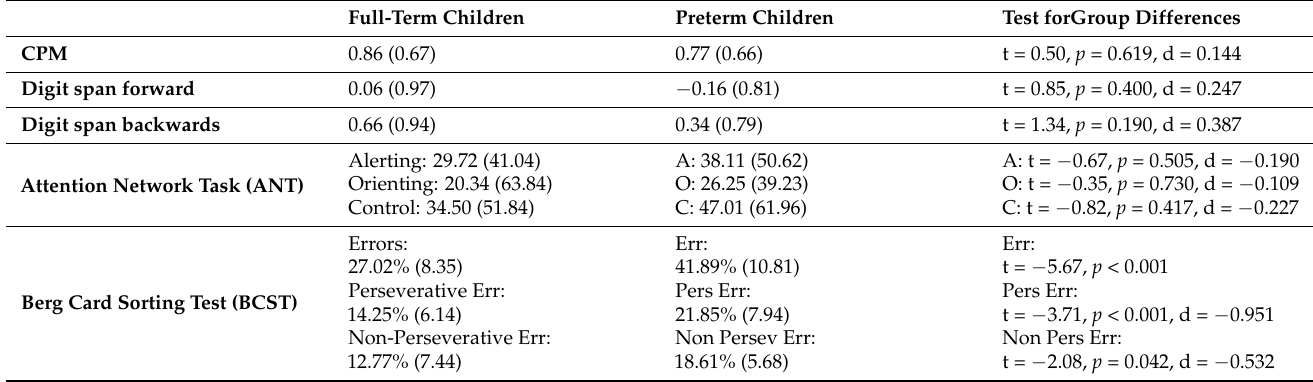
Table 2. Descriptive statistics and analysis for between-group comparisons for each cognitive